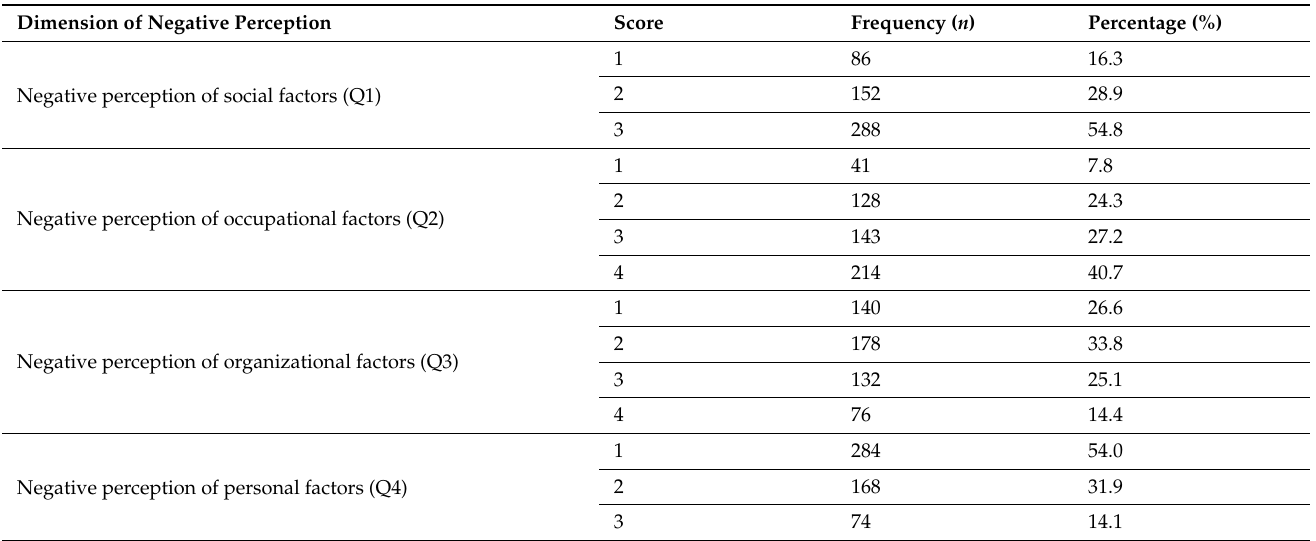
Table 5. Scores of negative perception